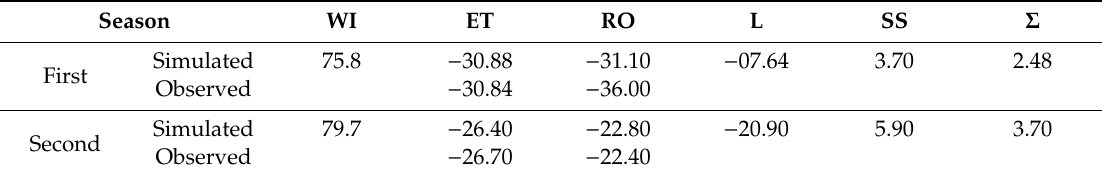
Table 5. Simulated and observed water balance components (cm) in the soil profile during two seasons of sweet corn in MARDI,